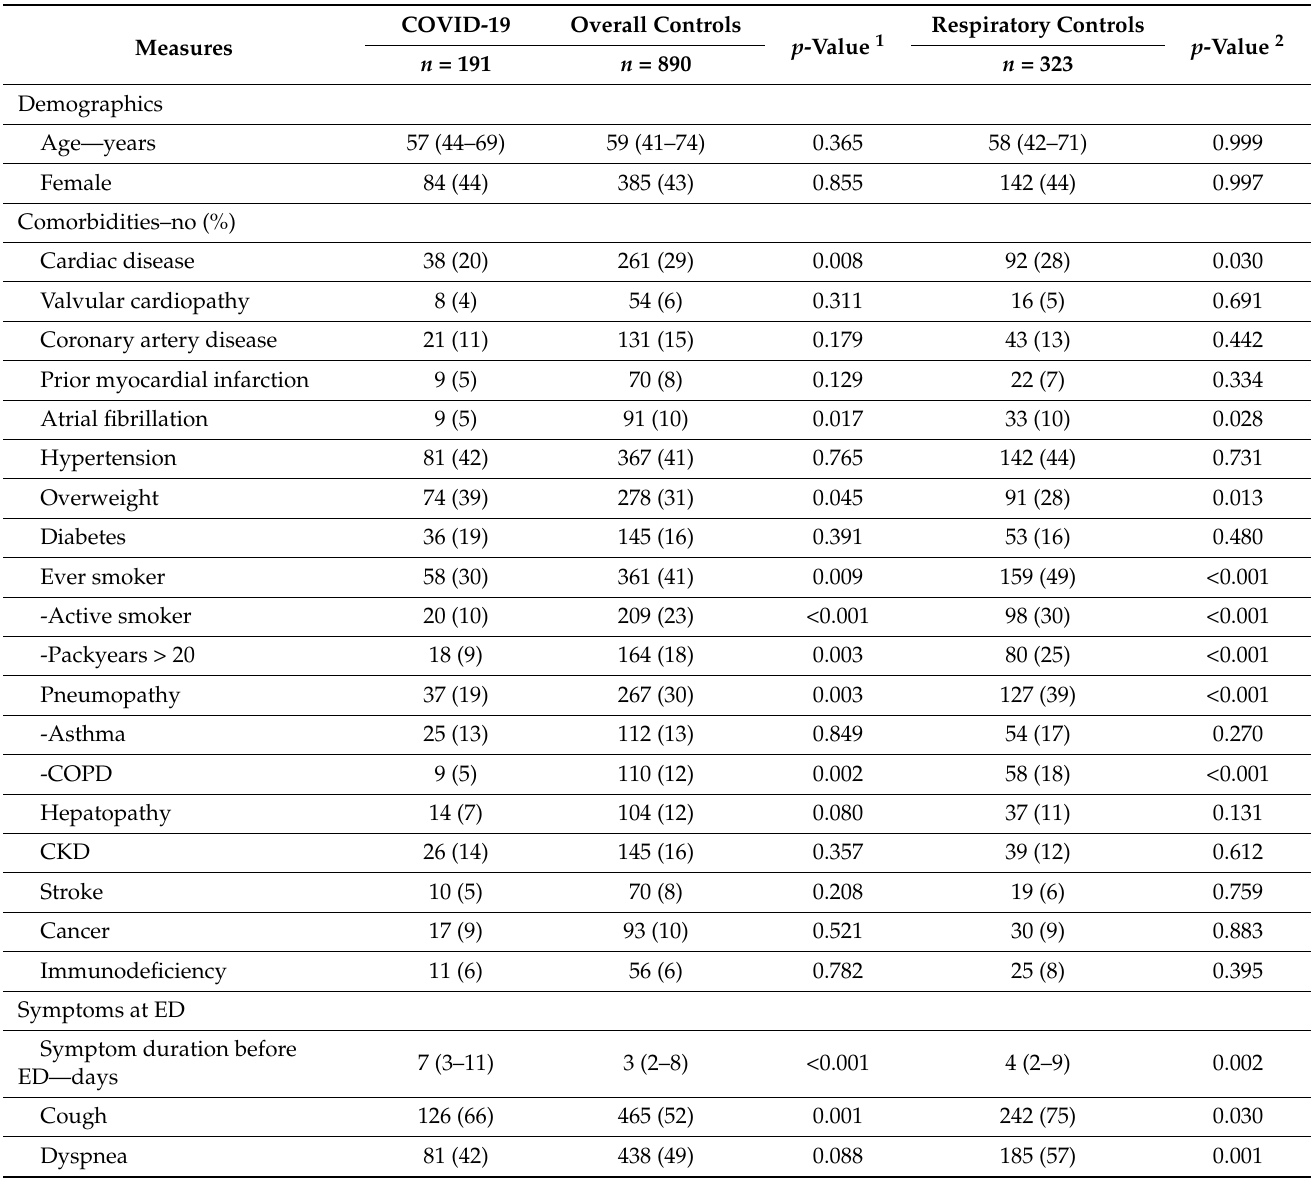
Table 1. Baseline characteristics in COVID-19 and